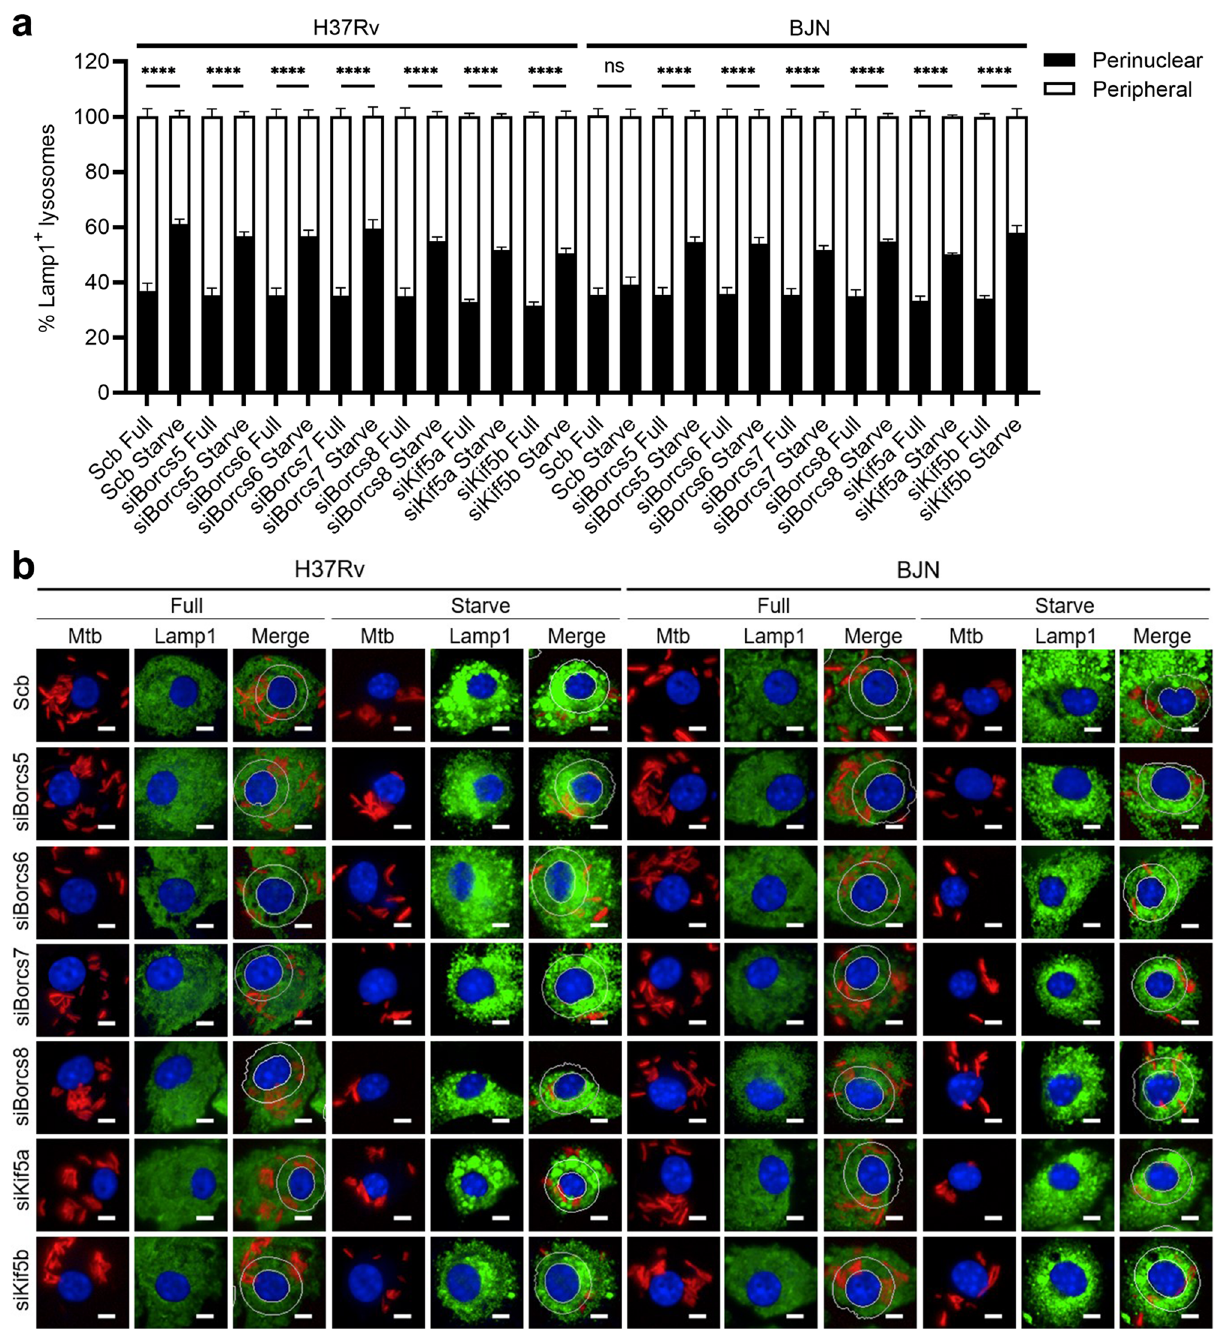
Figure 5. BORCS5-8 and Kinesin-1 dampen lysosome relocation to the perinuclear area in the BJN-infected BMDMs. ( a,b ) BORCS5-8- and Kinesin-1-depleted BMDMs were infected with the mCherry-expressing H37Rv or BJN for 15 min and chased for 1 h, as in Fig. 4. Autophagy was then induced by starvation for 24 h. Cells were stained with anti-Lamp1 antibody and Hoechst and then processed for high-content image analysis. The number of Lamp1 + lysosomes in each cytoplasmic subregion of the mycobacteria-infected BMDMs was quantified. The percentage of perinuclear Lamp1 + lysosomes (0–4 µm distance from the nucleus) and peripheral Lamp1 + lysosomes (4 µm from the nucleus and cell boundary) were then calculated and compared. Data are means ± SEM from at least three independent experiments; ns, non-significant and ****p < 0.0001, all relative to the full control determined by one-way ANOVA with Tukey’s multiple comparison test ( a ). Representative images with a line specifying the perinuclear region (0–4 µm distances from the nucleus) are shown in ( b ). Bar 5